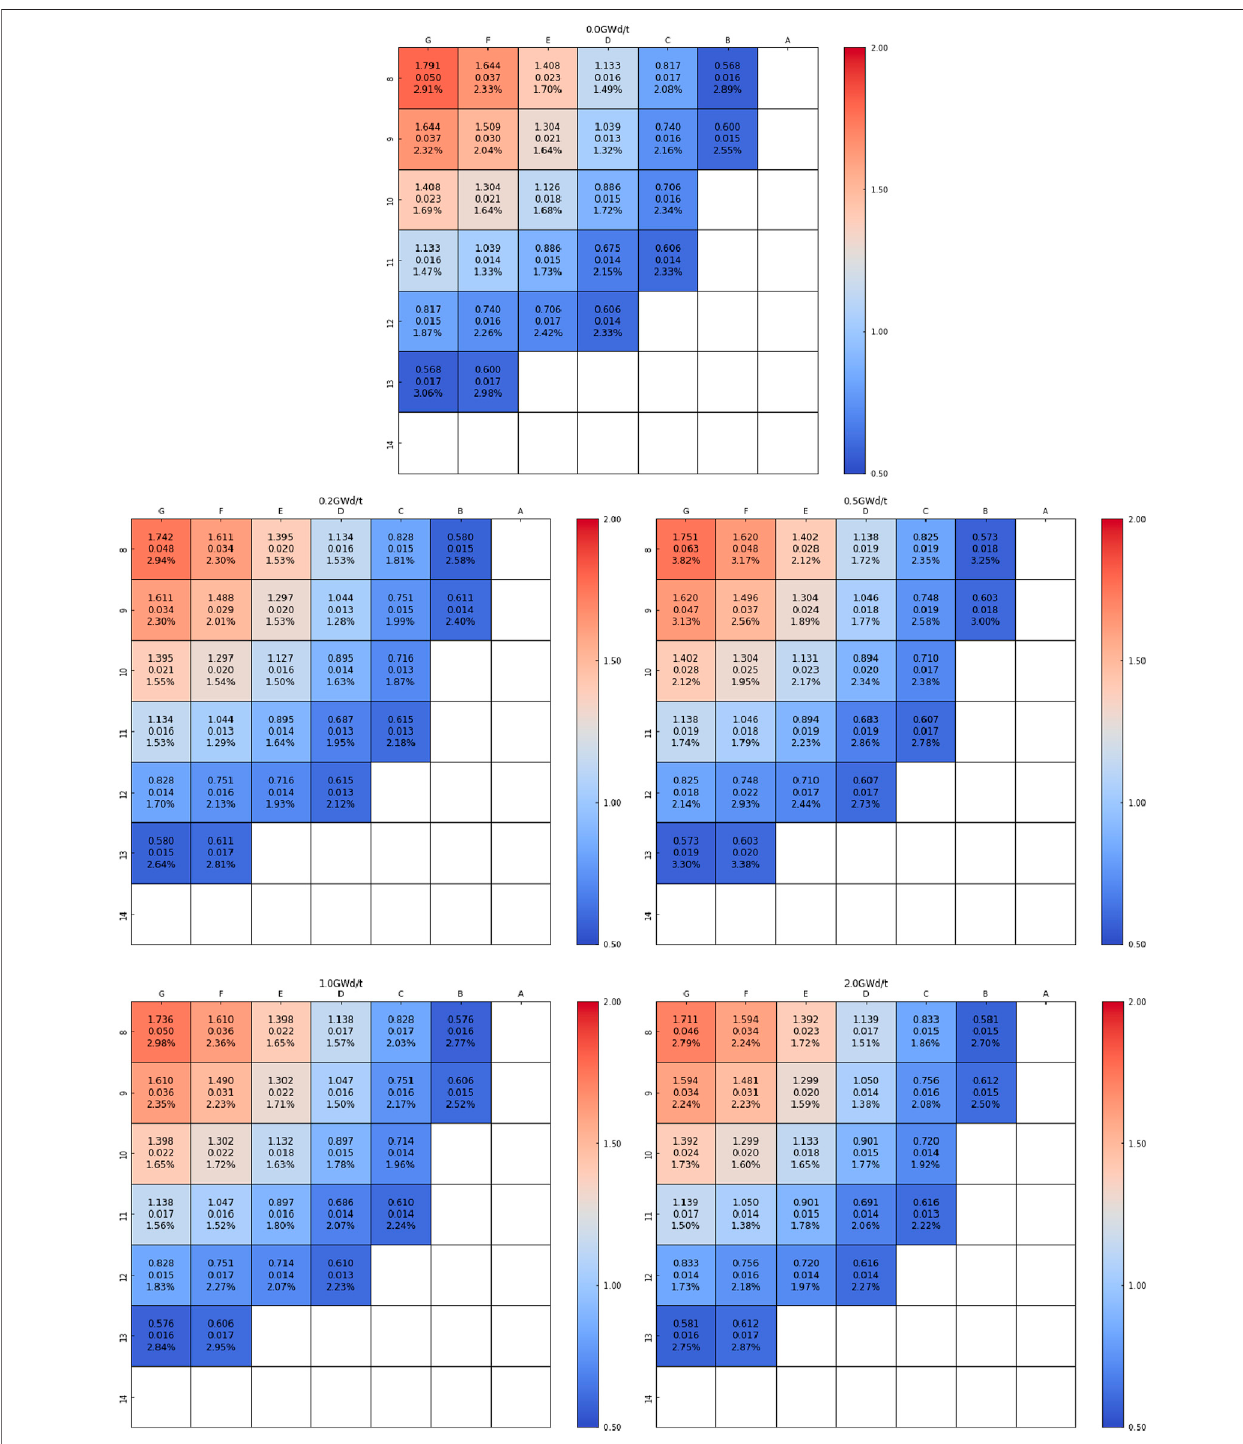
FIGURE 9 | Power distribution prediction result of the BOC. First line: assembly average power. Second line: mean absolute error. Third line: average value of absolute relative error.